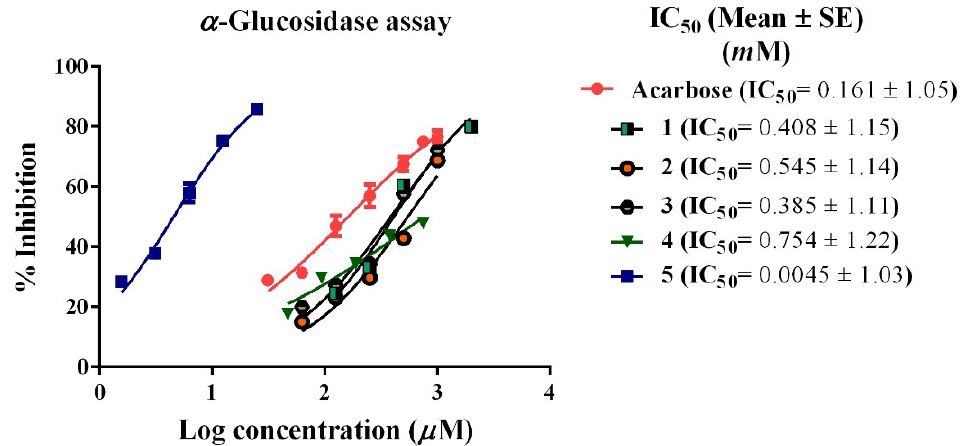
Figure 2. α -Glucosidase inhibitory effect of the isolated compounds ( 1-5 ) from C. oblongifolia and